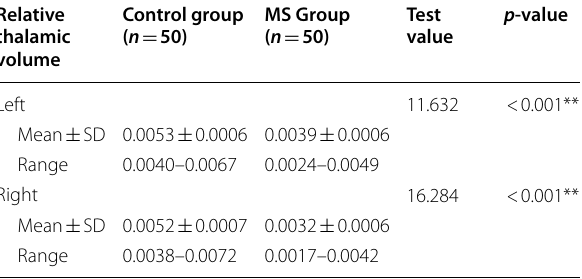
Table 1 Comparison between control groups and MS group according to relative thalamic volume